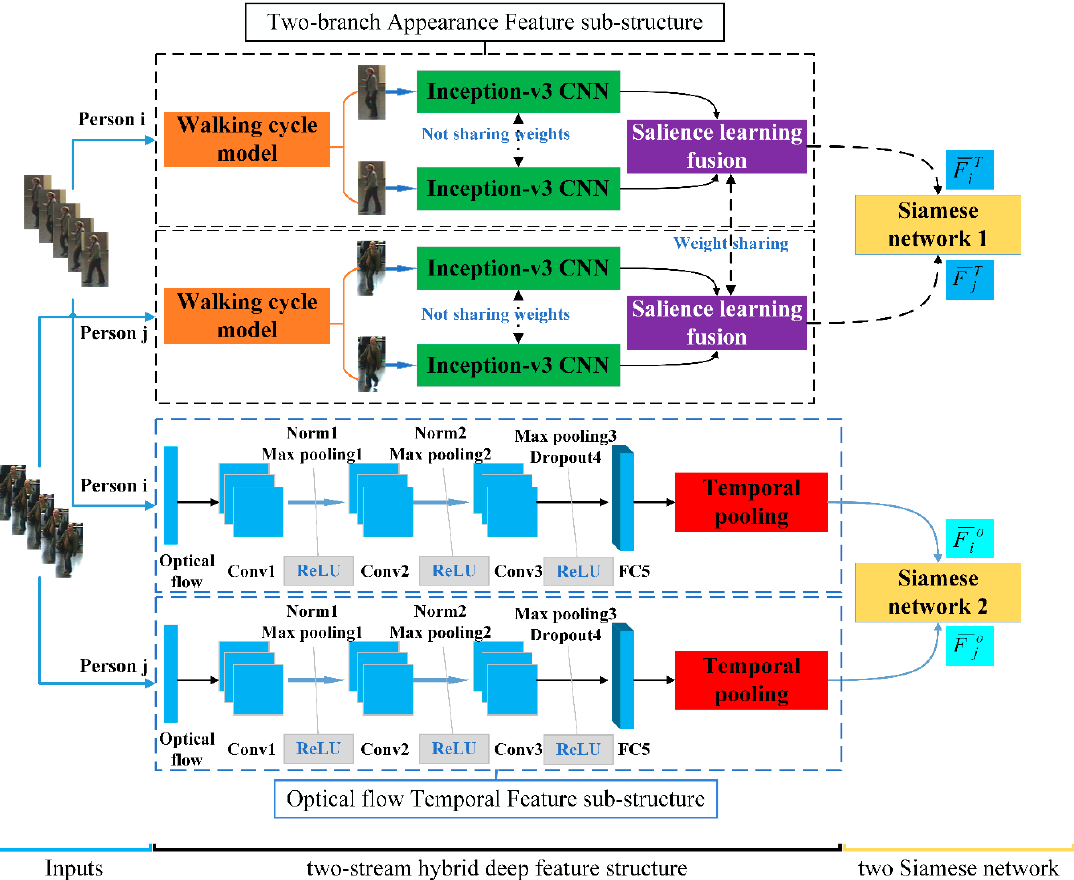
Figure 2. The framework of the proposed hybrid end-to-end deep learning architecture. The architecture consists of inputs, a two-stream hybrid deep feature structure, and two Siamese networks. The two-stream hybrid deep feature structure is composed of the Two-branch Appearance Feature sub-structure and the Optical flow Temporal Feature sub-structure, which can obtain abundant appearance information and stability temporal information of the pairwise